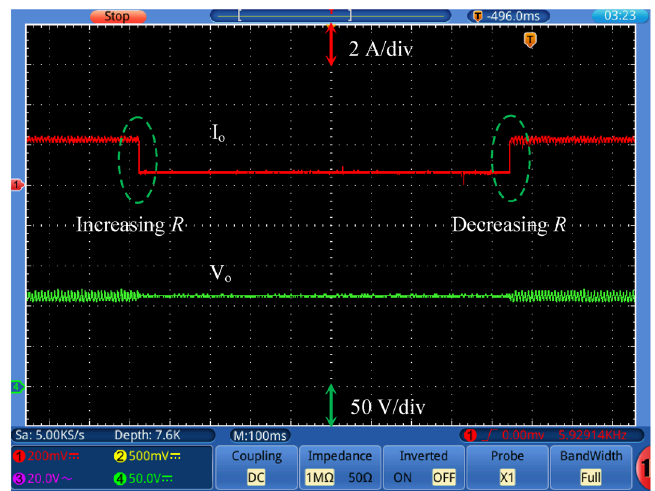
Figure 19. Output voltage response with changing the load value at V ref = 115 V.